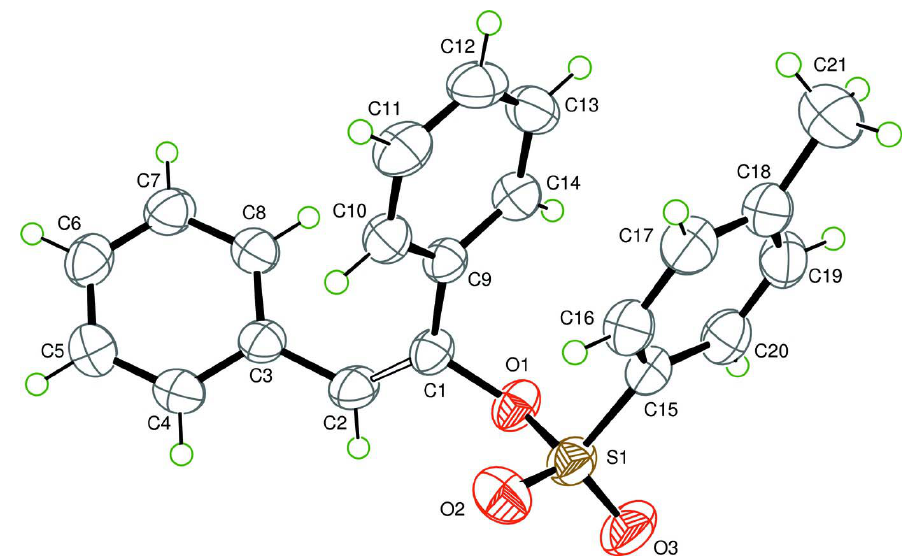
Figure 1 Molecular structure of the title compound, showing 30% probability displacement ellipsoids and atom numbering